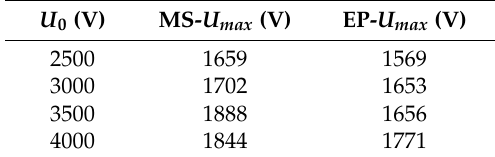
Table 2. Peak voltage of two samples under di ff erent U 0 at R max .